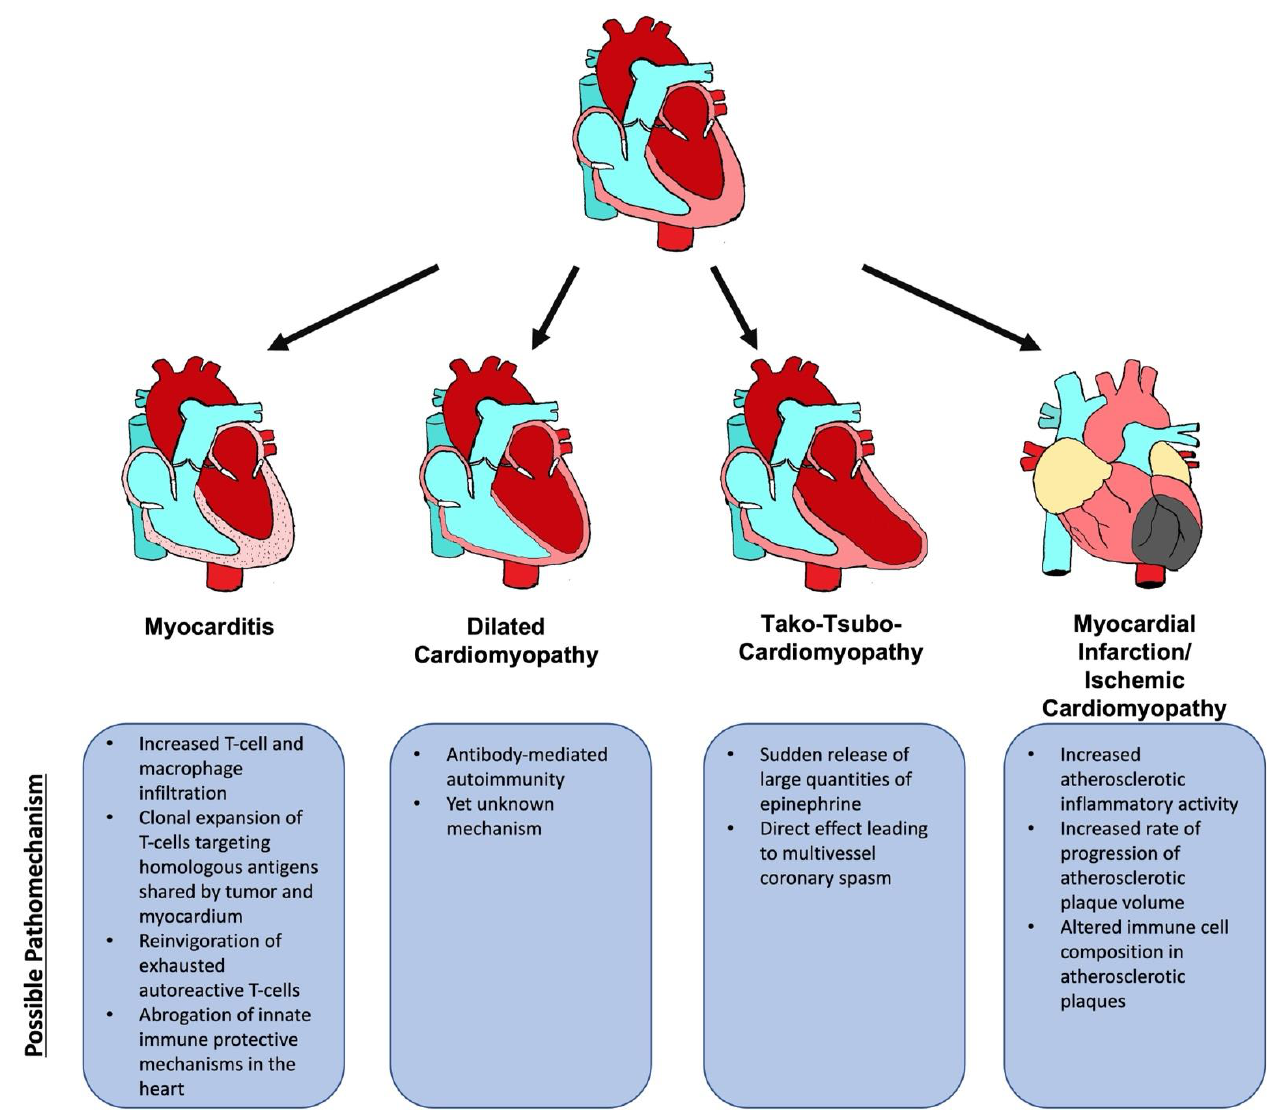
Figure 2. ICI-induced cardiomyopathies and possible underlying pathomechanisms. Besides myocarditis, non-inflammatory cardiomyopathies, such as dilated cardiomyopathy, Tako-Tsubo-cardiomyopathy, myocardial infarction, and ischemic cardiomyopathy, have been observed under ICI therapy.